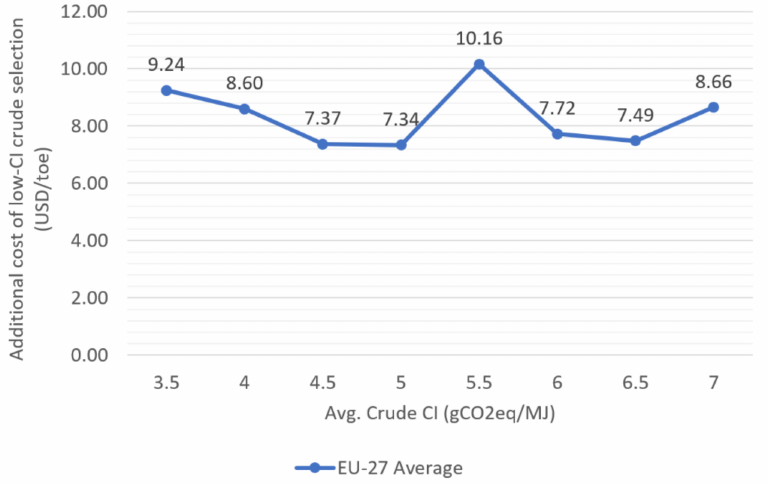
Figure 3. Average additional cost of low-CI crude selection compared to EU average crude